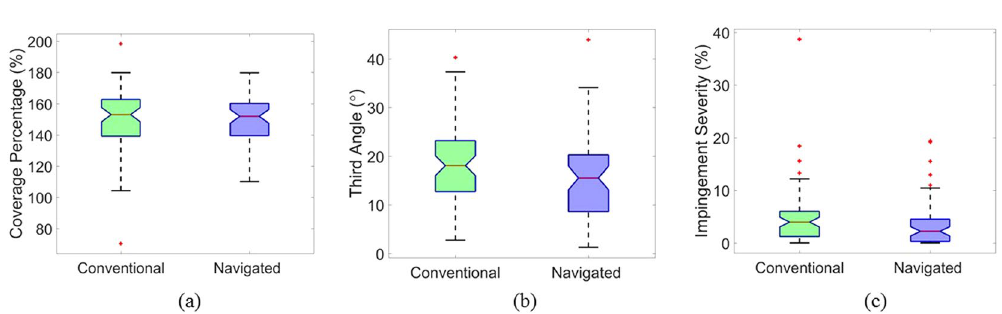
Figure 5. Box plot of ( a ) Coverage percentage, ( b ) third angle, ( c ) impingement severity for ITI impingement.